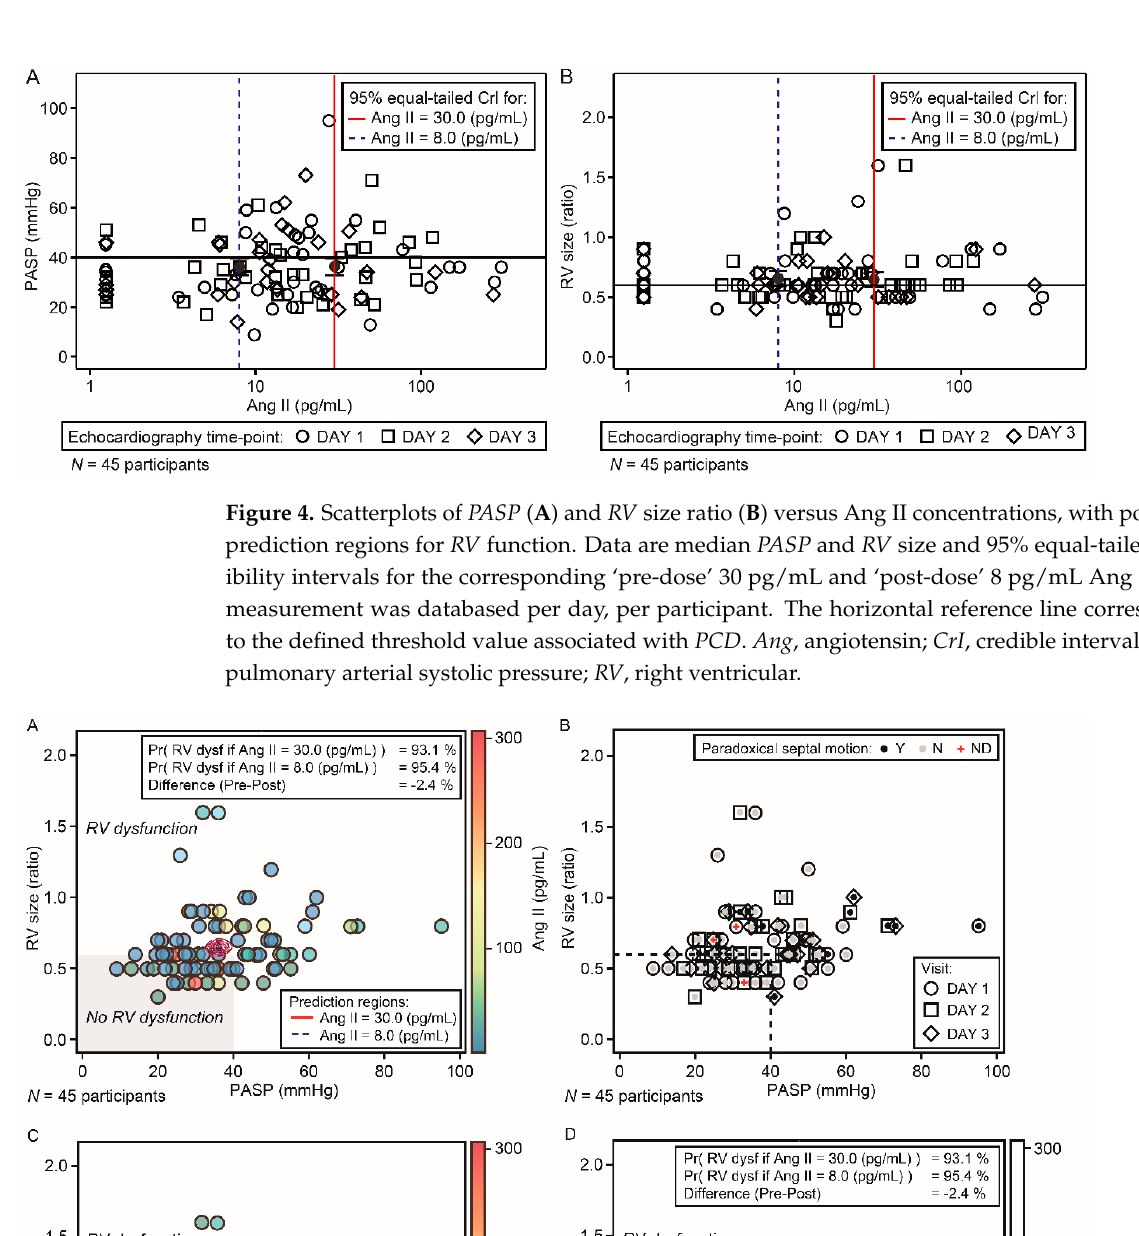
Figure 3. Individual time profile of ( A ) Ang II and ( B ) Ang(1–7) concentrations by time point. Ang angiotensin.